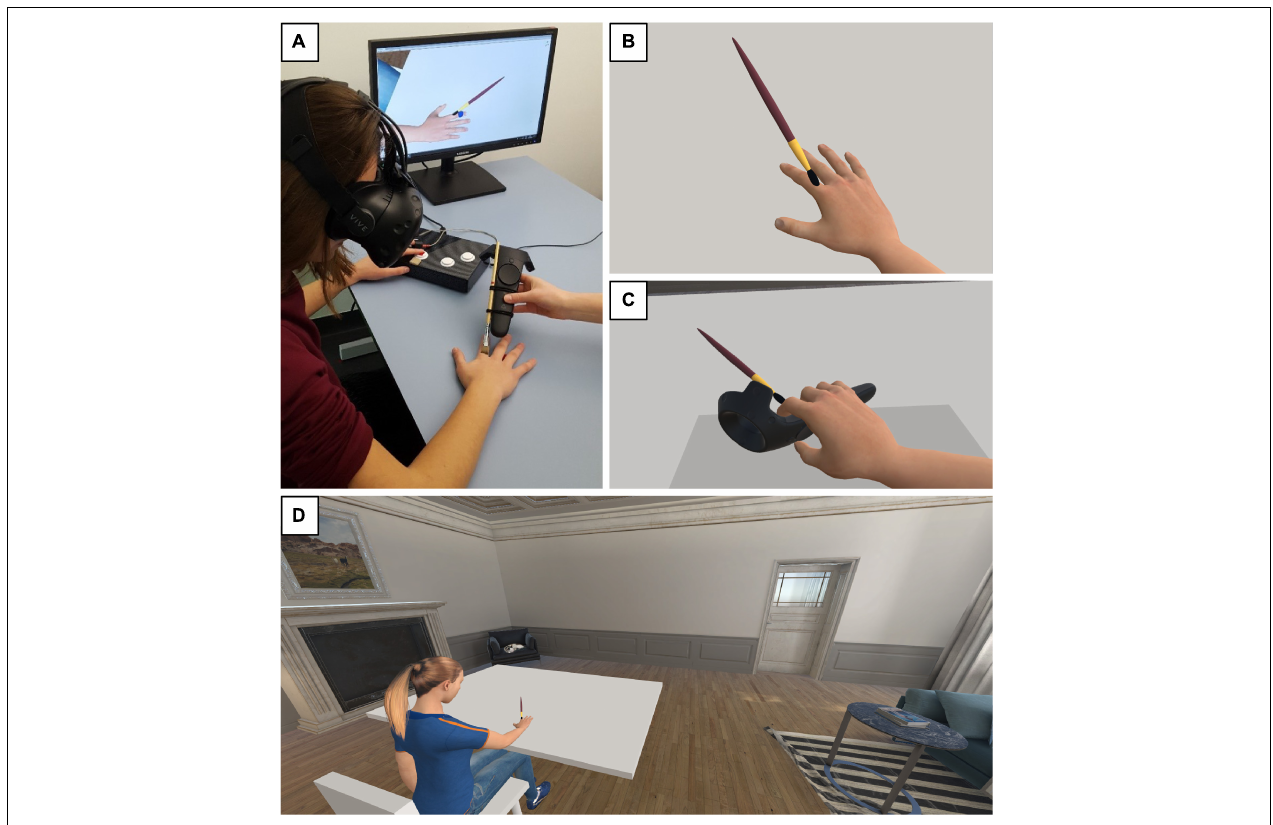
FIGURE 1 | Experimental setup and VE. (A) A participant performing Task 1. Her index finger is stroked in a congruent mode and her left hand is on the response box. The blue dot seen on the virtual finger on the researcher’s screen indicates to the researcher which finger to stroke. By pressing the trigger button on the controller, the virtual brush appears. The virtual brush moves accordingly to the real brush attached to the controller and disappears as soon as the fingertip is reached. (B) Participant’s first-person perspective point of view in the VE during Task 1. The blue dot is not visible. (C) Participant’s first-person perspective point of view in the VE during Task 2. (D) Overview of the VE, including the female version of the